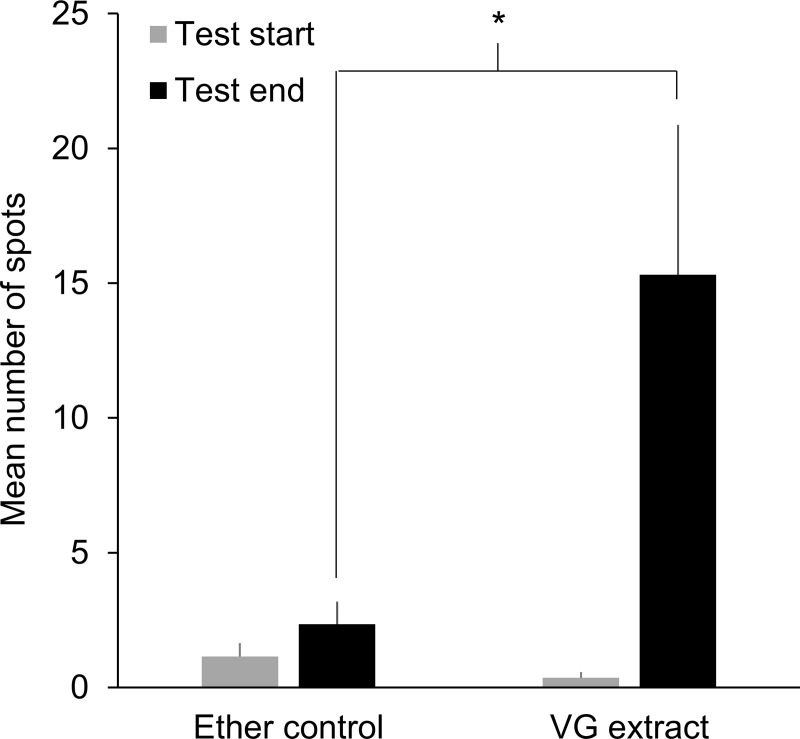
Fecal spotting on hive fronts increased after colonies were exposed to VG extracts.Each extract mixture was created by placing VGs from three Vespa soror workers into a vial with 0.5 mL ether for 24 hours (one vial per test colony). A 1 cm2 piece of filter paper was repeatedly soaked and dried in this mixture before it was pinned at a colony entrance; ether shams (filter papers without extracts) were created similarly and presented to colonies as a control. Hive fronts were photographed after six hours to determine changes in spot number. Asterisk indicates a significant difference between treatment means (± SEM) by the end of the test (p = 0.02).